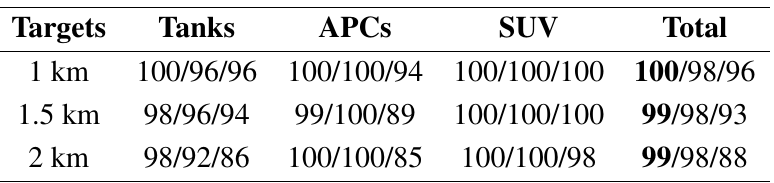
Table 4. Recognition accuracy (%) for Methods I, II and III. (Reprint from [28], with permission from